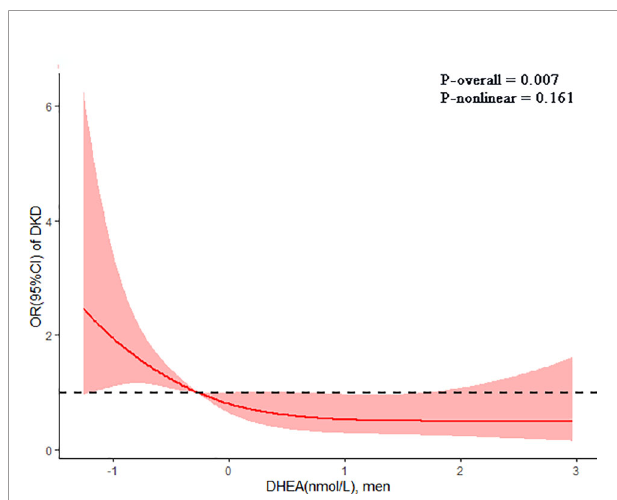
FIGURE 4 | The dose-response association of dehydroepiandrosterone (DHEA) with diabetic kidney disease (DKD) in men shown by the restricted cubic spline. The line indicated the adjusted ORs for serum DHEA levels in men. 95% CI was shown by shaded areas. Adjust for age, current smoking, current drinking, insurance type, BMI, duration of diabetes, dyslipidemia, SBP, DBP, FBG, HbA1c, UA, and use of RAAS and SGLT2